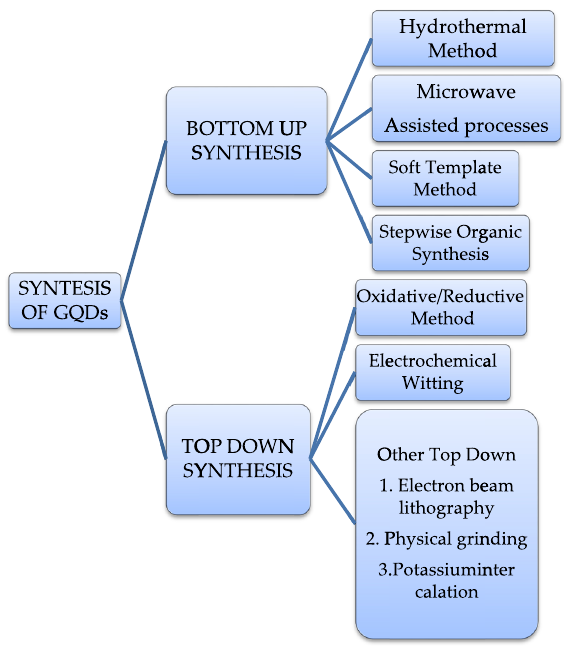
Table 2: Synthesis of